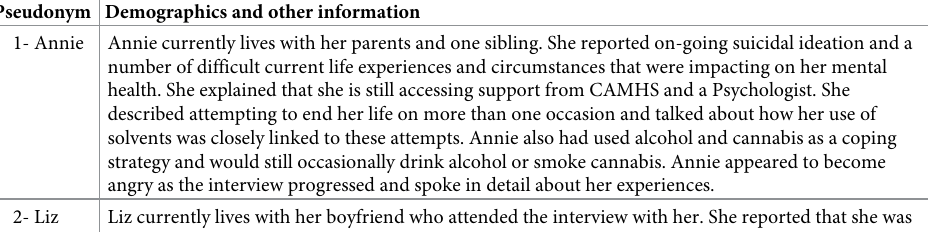
Table 1. Information about the research participants. Pseudonym Demographics and other